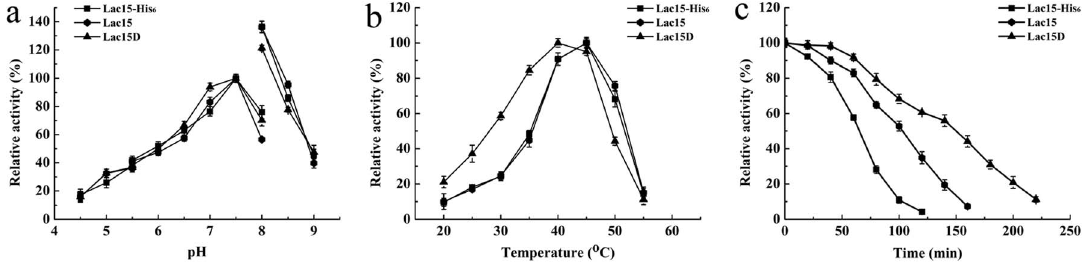
Figure 3. Effects of pH and temperature on the activity and stability of laccase proteins. (a) pH optimum. Laccase activity was determined in 50 mM sodium citrate buffer (4.5–5.5), Na 2 HPO 4 –KH 2 PO 4 buffer (5.5–8.0), and Tris–HCl buffer (8.0–9.0). (b) Temperature optimum. Laccase activities were measured by incubating proteins at each optimal pH. (c) Temperature stability. Proteins were incubation at 45 u C at pH 7.5. The data presented are the average values from triplicate technical repeats of